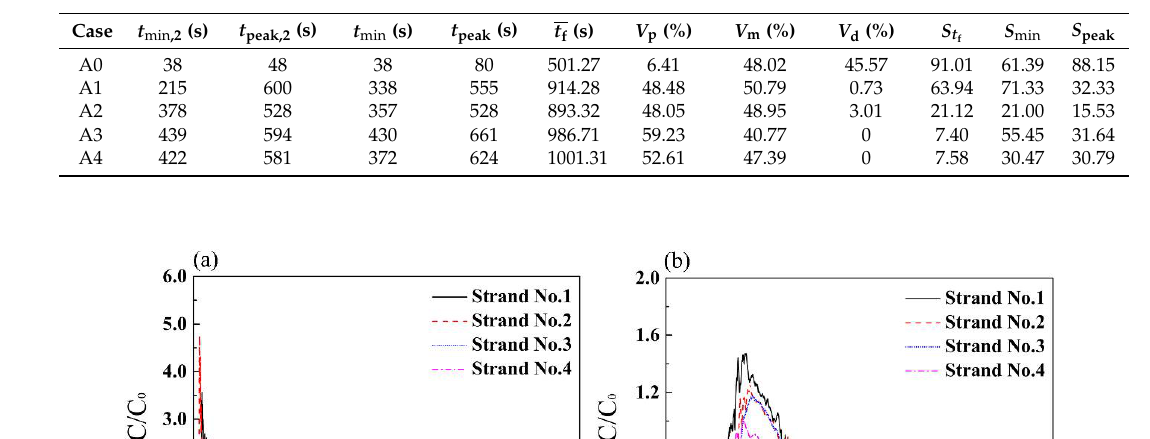
Table 8. Characteristic parameters of non-isothermal experiment cases.